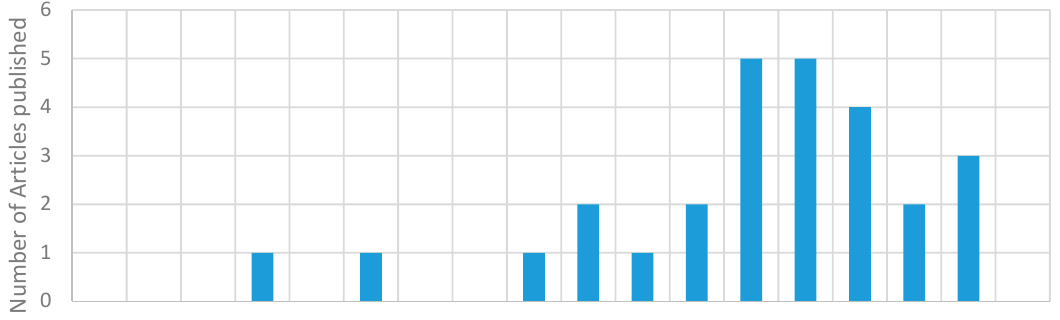
Figure 6. Distribution of reviewed literature over the time scale.